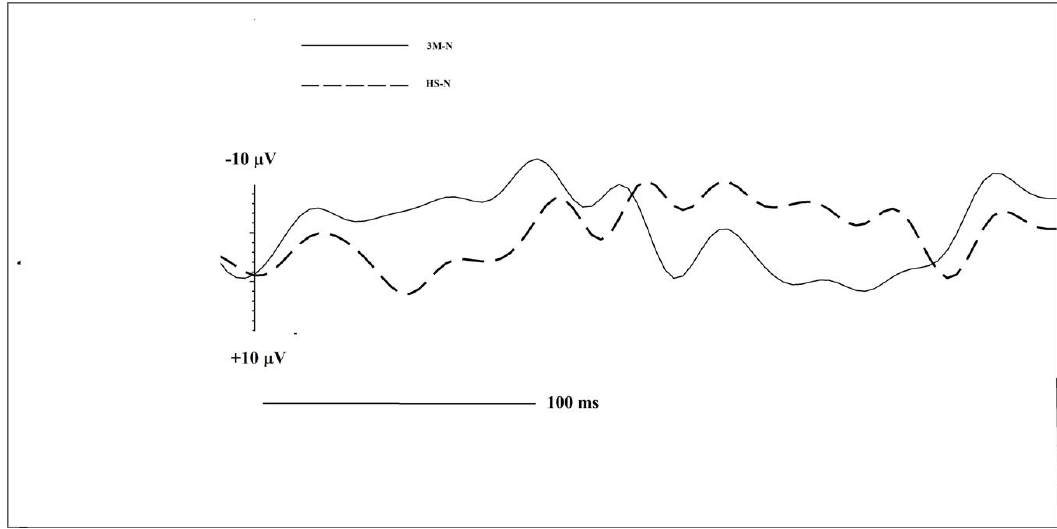
Figure 2. Central left ROI comparison of CSERPs components for 3M-N (black continuous line) and HS-N (dashed line) subjects.